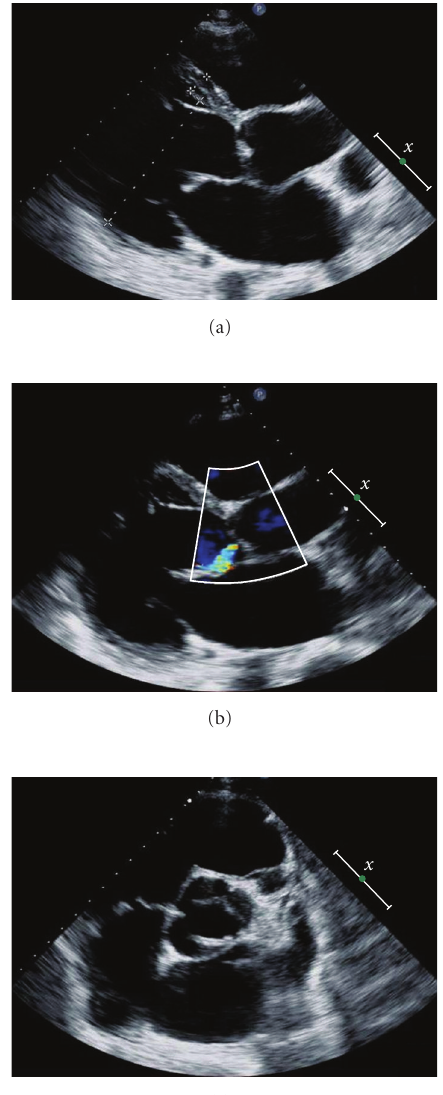
Figure 2: Transthoracic echocardiography. (a) and (b) Apical four-chamber view, characteristic, multiple, prominent muscular trabeculations and intertrabecular recesses. (c) Color Doppler mode, blood flow within the deep intertrabecular